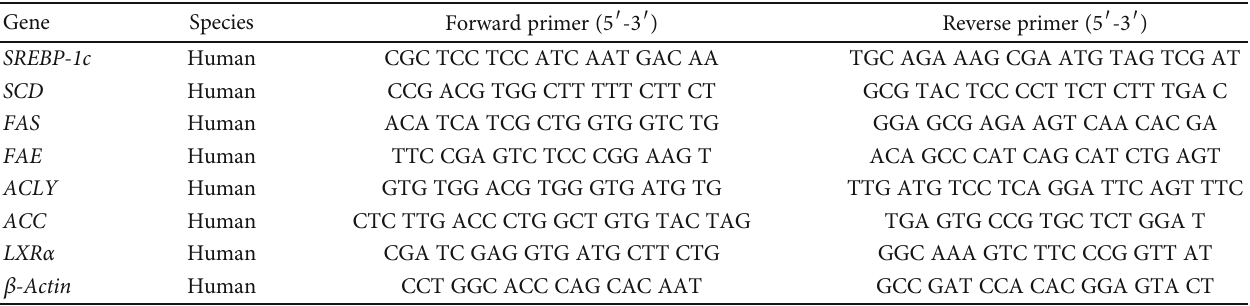
Table 1: Sequences of PCR